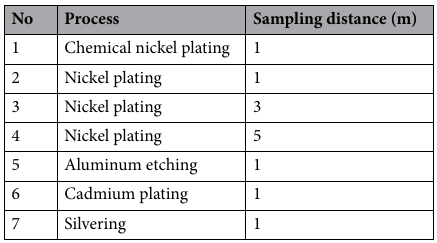
Table 2. Particle concentration measurement